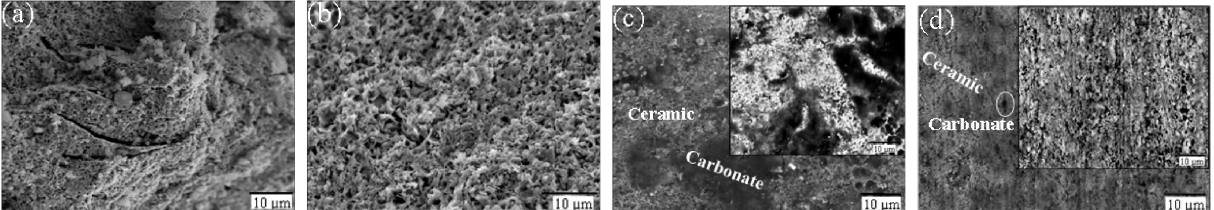
Fig. 7 SEM images of the cross section of (a) 50CP–50PSFC ceramic support, (b) 75CGCO–25LCF ceramic support, (c) 50CP–50PSFC/carbonates, and (d) 75CGCO–25LCF/carbonates dense dual phase